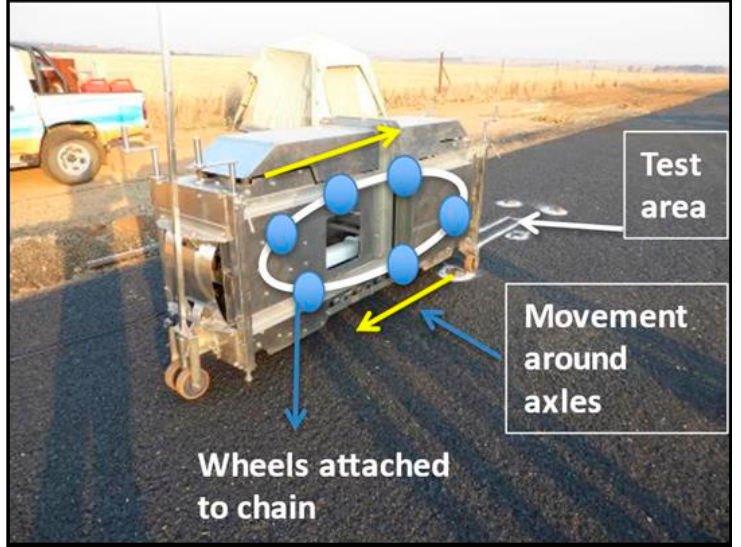
Figure 6. Graphical illustration of the setup and working of the 3rd Model Mobile Load Simulator (MMLS3) on-site.